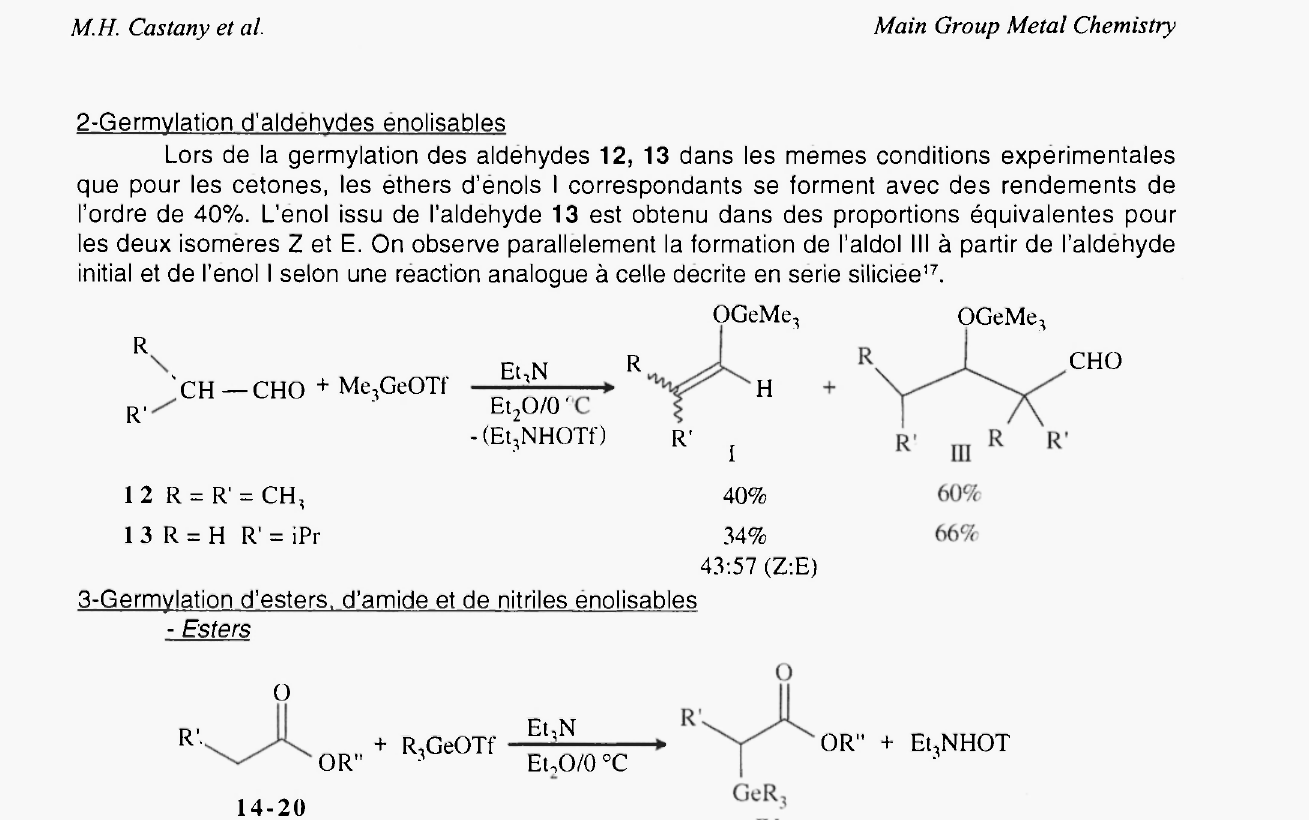
formation du cetene O-alkyl O-trialkylgermylacetal. Notons qu'en serie siliciee, les groupements R